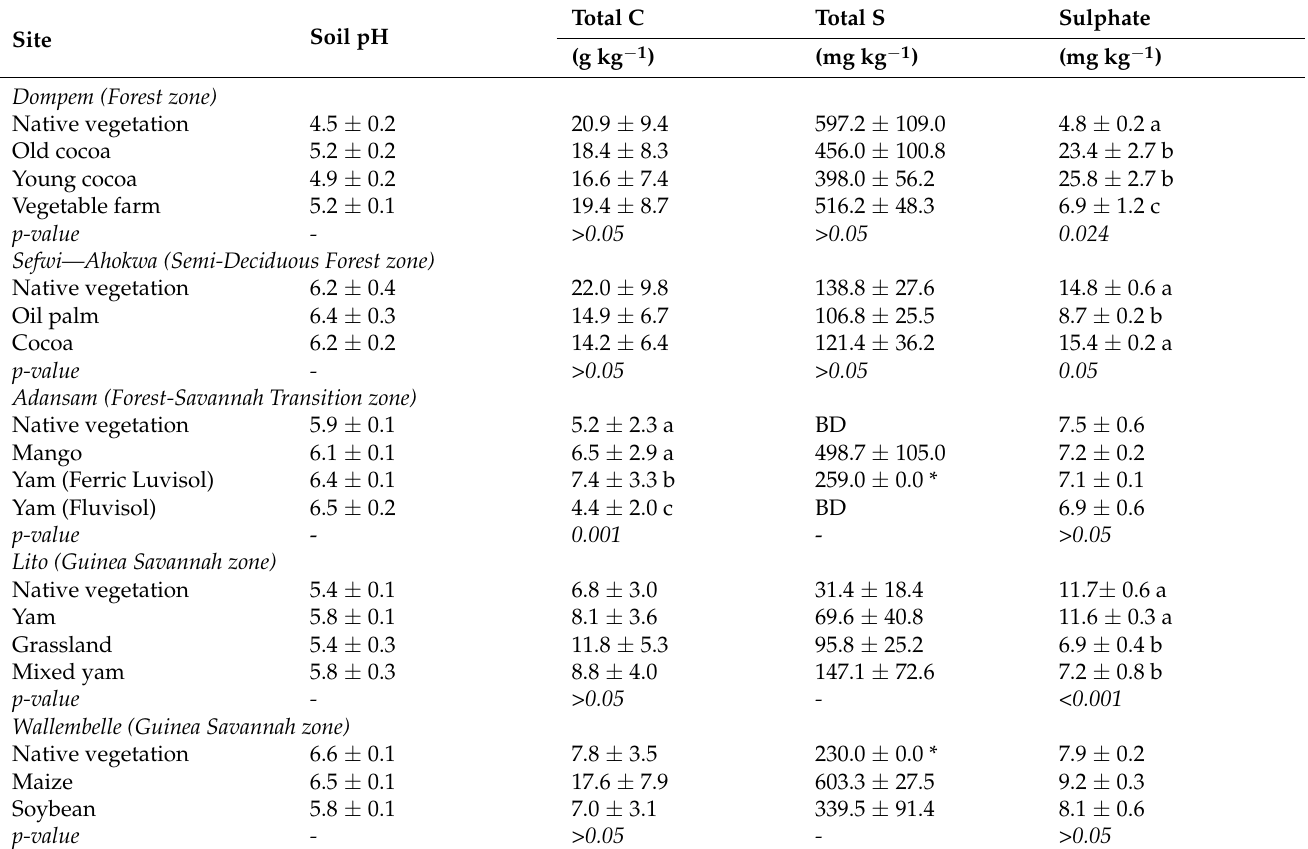
Table 2. Soil pH, total C, N, S and sulphate contents of soils from native vegetation and croplands the reconnaissance survey sites ( n = 5 ± One standard error of